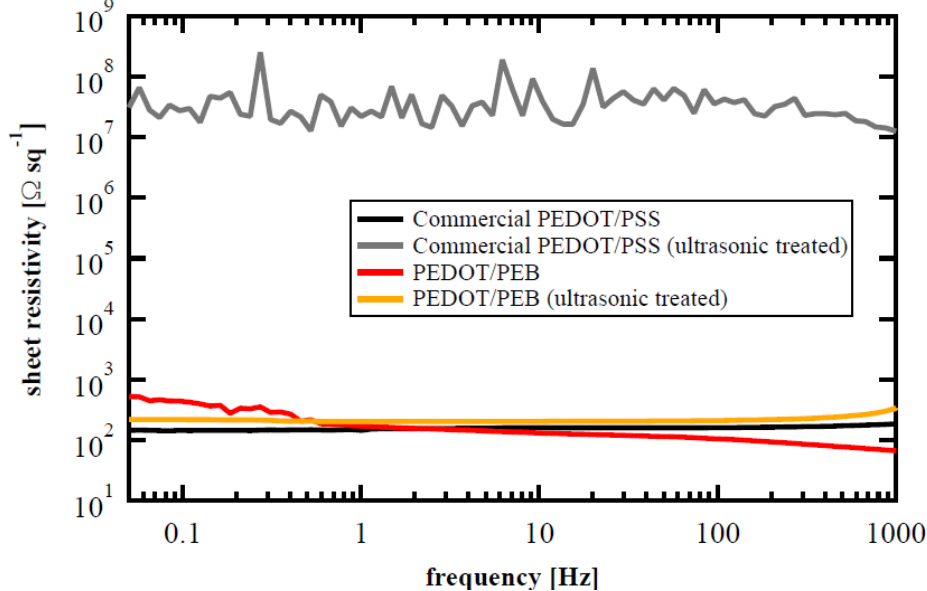
Figure 4. Sheet resistivity spectra of the PEDOT/PEB sample and commercial PEDOT/PSS film before and after ultrasonic treatment in water. The PEDOT/PEB sample maintained its conductivity even after ultrasonic treatment.